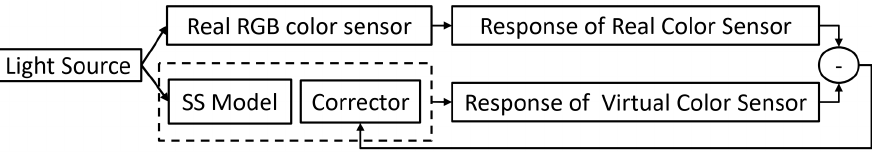
Figure 5. Optimization pipeline for correcting the measured spectral sensitivity (SS) model. The correction is performed on the color sensor’s sensitivity curves by introducing suitable wavelength- specific correction factors that minimize the differences between real (measured) and virtual (calcu- lated from the SS model times correction factors) sensor responses.